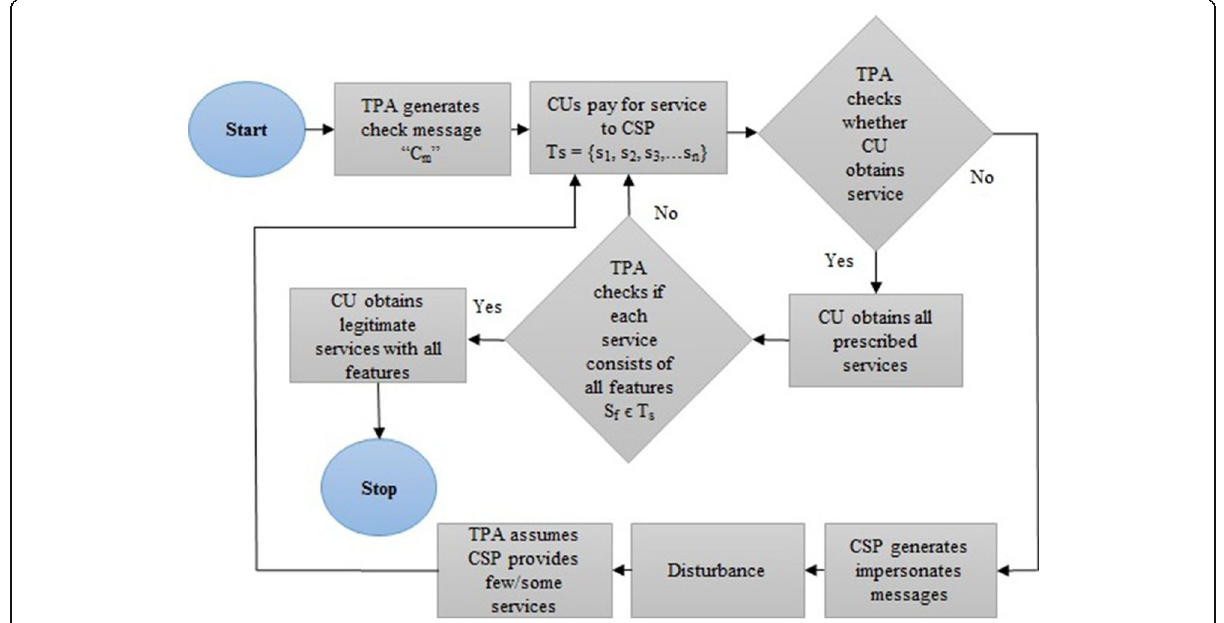
Fig. 6 Identifying the authentication process of CSP for fulfillment of data-privacy